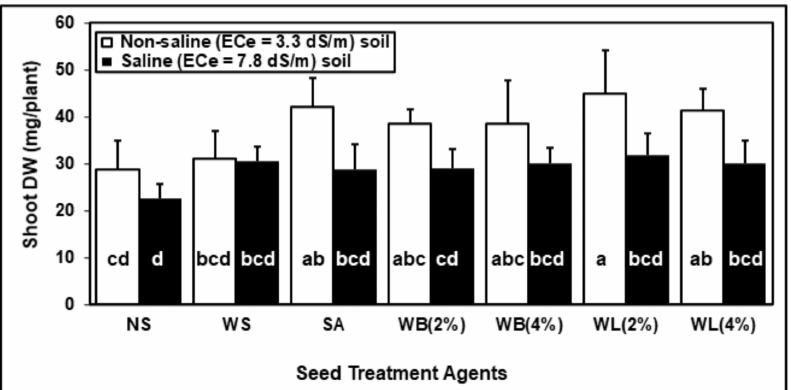
Figure 5. Effect of seed treatment with various agents (NS, non-soaked; WS, water-soaked; SA, salicylic acid (0.5 mM); WB, willow bark extract (2% or 4% w / v ); WL, willow leaf extract (2% or 4% w / v )) on shoot dry weight (DW) of 2-week-old maize ( Zea mays cv. Caramelo) plants grown in non-saline (EC e = 3.3 dS/m) (white) vs. saline (EC e = 7.8 dS/m) (black)